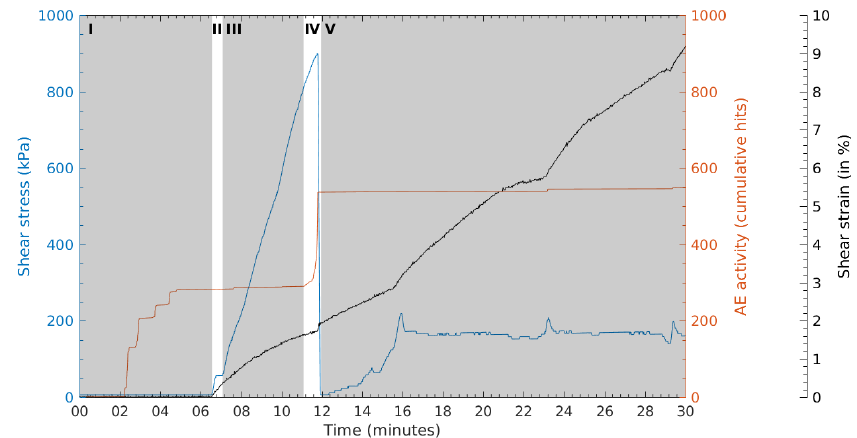
Figure 4. Typical curves of shear stress, shear strain and acoustic activity for a shear test at T = − 3 ◦ C and normal stress σ = 200kPa. Stages (I)–(V) represent the typical stages of each experiment: consolidation (I), sample fitting to shear rings (II), pre-peak shear deformation (III), shear failure (IV) and post-peak shear strength (V). Rupture is clearly detectable by the strong decrease in shear stress. An increase in the evolution of the cumulative AE hits can be observed before rupture.